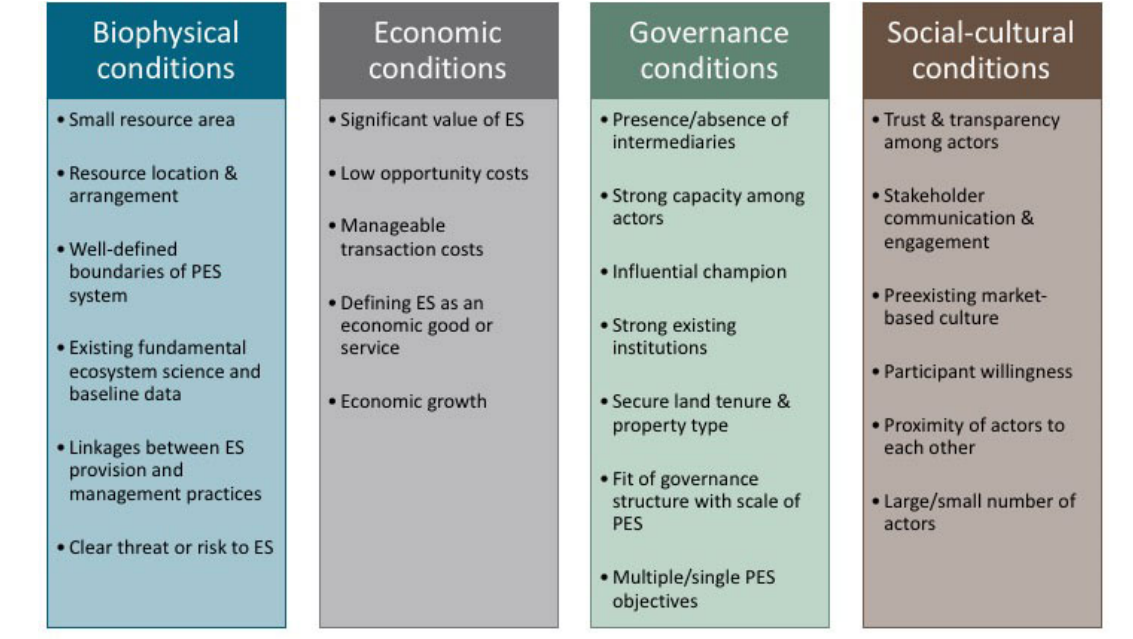
Fig. 1 . Enabling conditions for payments for ecosystem services (PES) programs identified from the